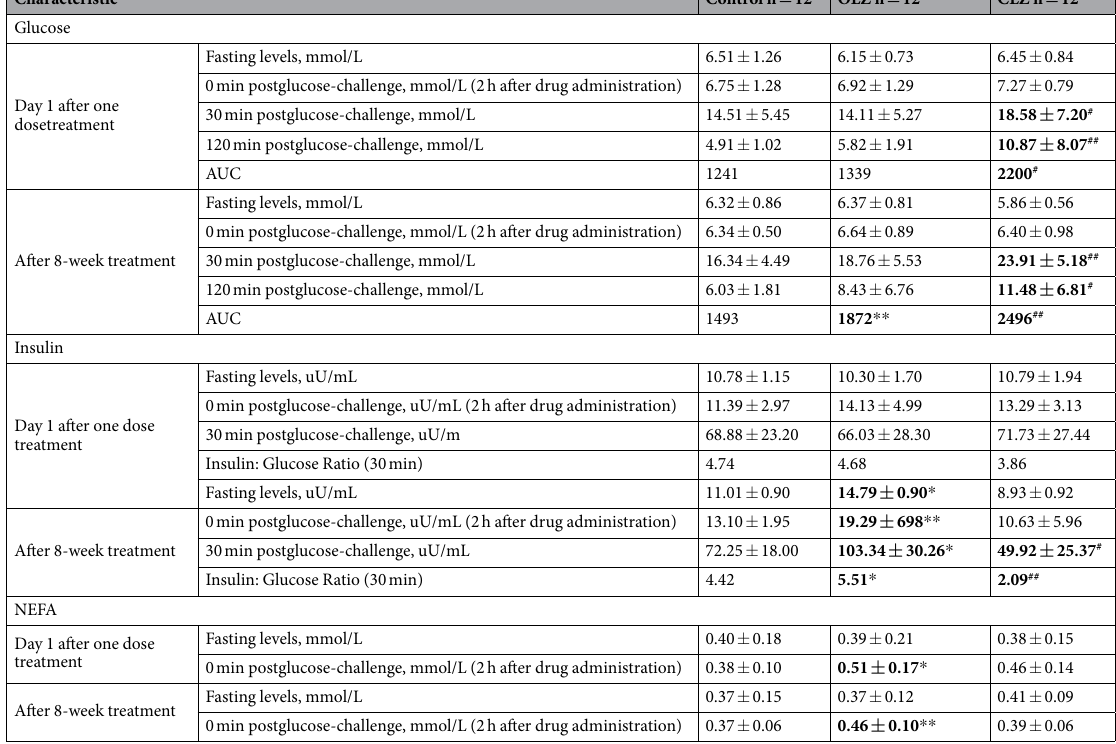
Table 1. Plasma glucose, insulin, and NEFA levels in response to one dose and 8-week drug treatment. Data were obtained from 12 rats per group and represent mean ± SD. Biochemical determinations were made in duplicate ( * p < 0.05 and ** p < 0.01: OLZ treatment vs. control, # p < 0.05 and ## p < 0.01: CLZ treatment vs.